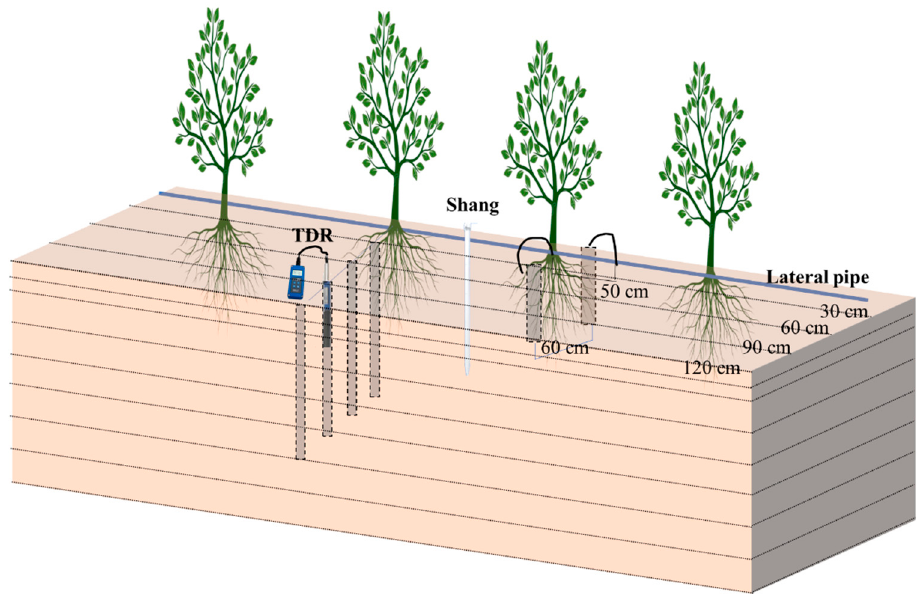
Figure 4. Locations of sampling points.